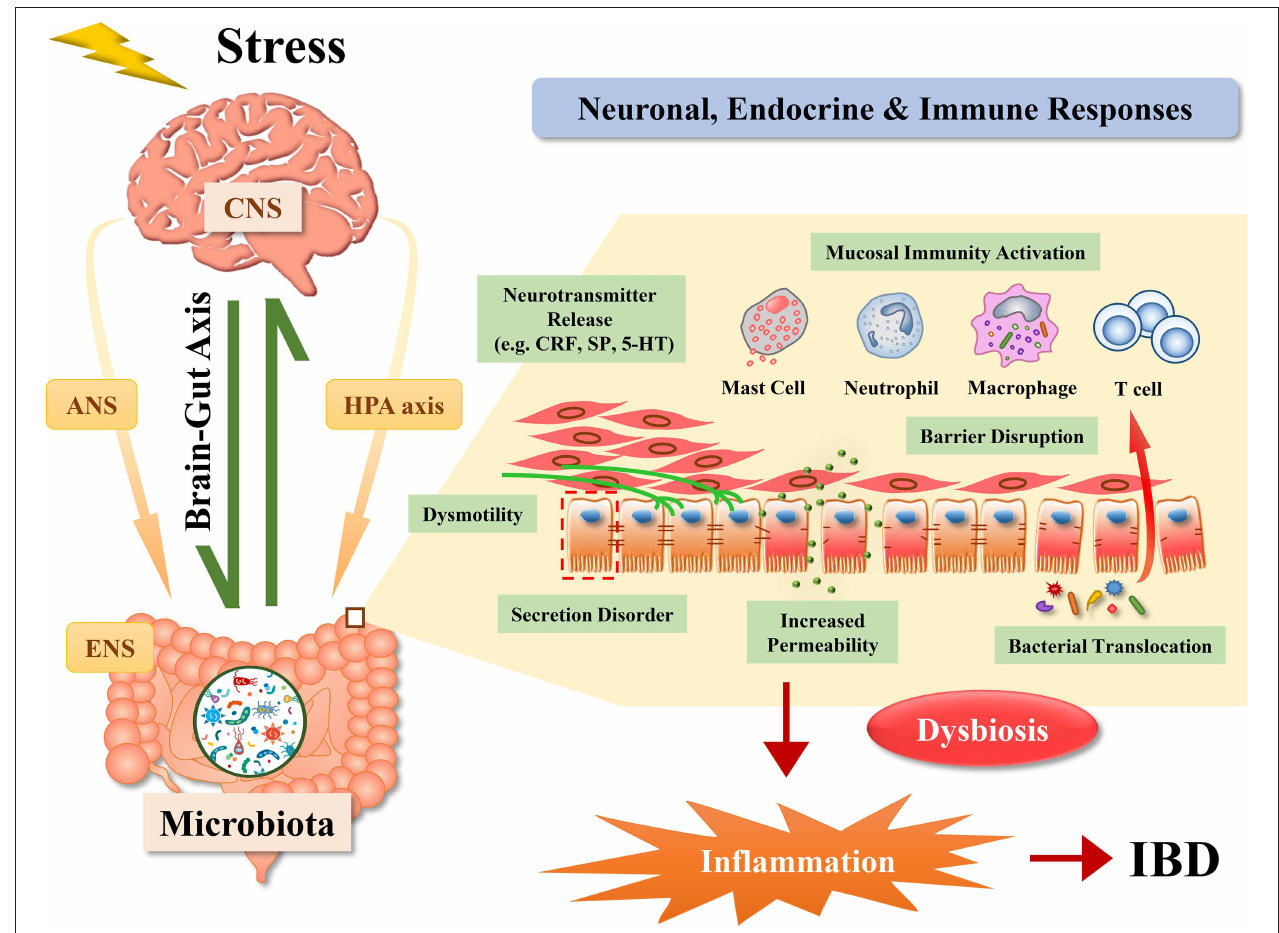
FIGURE 1 | Pathways by which stress affects inflammatory bowel disease. Effects of stress on the gut involve comprehensive reactions among neuronal, endocrine, and immune systems. Stress induces the activation of the brain-gut axis, the hypothalamic-pituitary-adrenal axis (HPA axis), the autonomic nervous system (ANS) and the enteric nervous system (ENS), contributing to the development of inflammatory bowel disease (IBD) via dysbiosis, alterations of secretion and mobility, disruption of the intestinal barrier and the release of inflammatory mediators. CNS, central nervous system; CRF, corticotrophin releasing factor; SP, substance P; 5-HT,